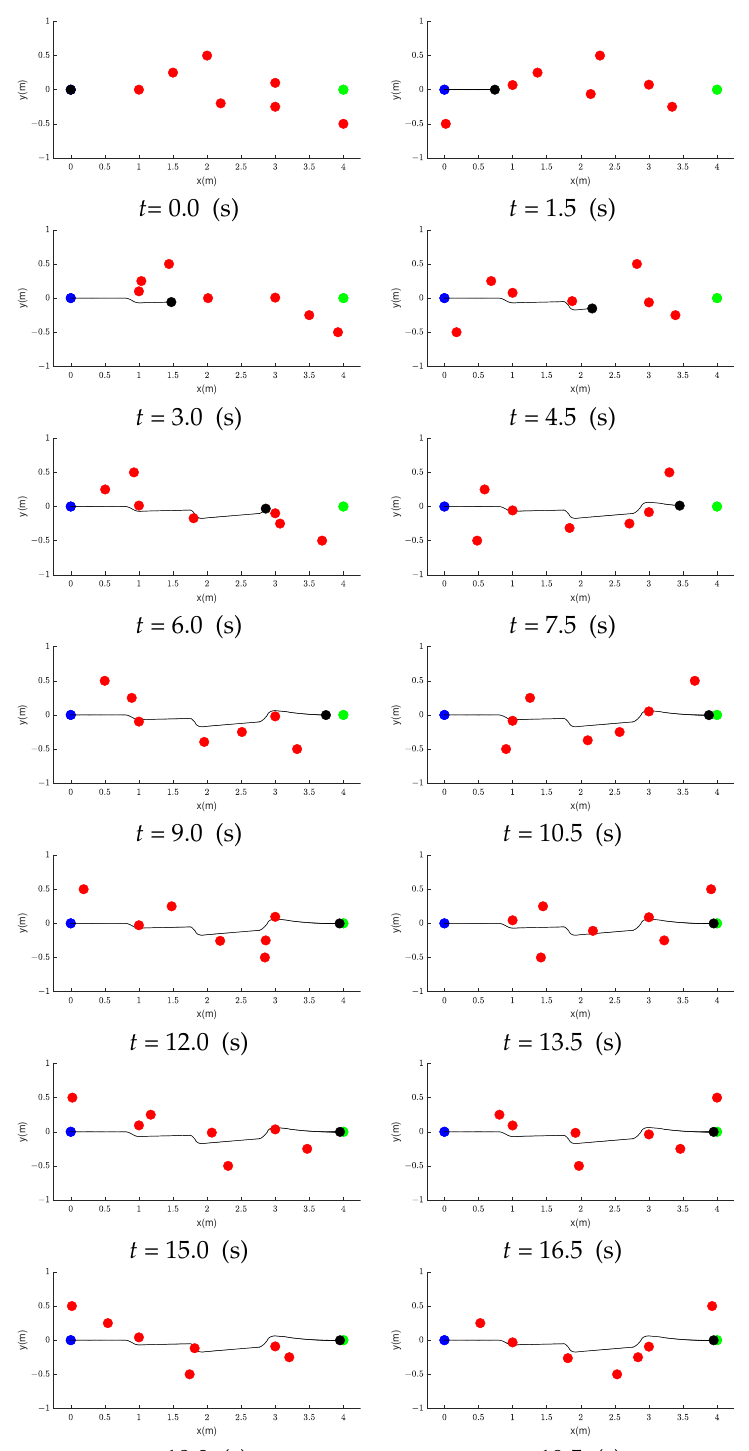
Figure 4. Behavior of D-Bug0/PSO for an arbitrary run. The complete scenario is shown every 1.5 (s). Tables 6 and 7 include the results obtained with Bug0 − and Bug0 + (i.e., Bug0 with fixed parameters and different obstacle avoidance directions), respectively, after 30 inde- pendent runs under the same experimental conditions as D-Bug0/PSO. The first column of these tables shows the number of the run, and the following columns show the travel distance, the number of times the robot collided with the dynamic obstacles, the time it took for the robot to reach the goal, the speed and the time it took for the computer